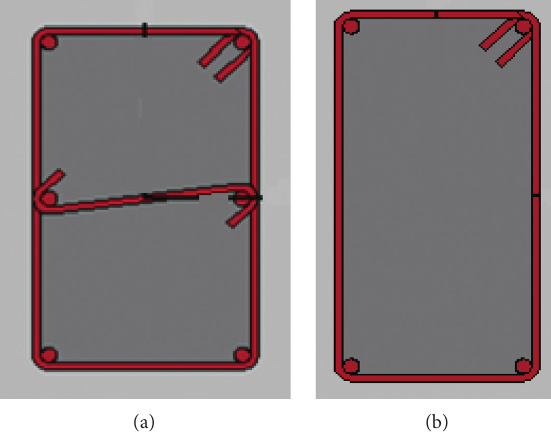
Figure 7: Structural detailing of (a) column detailing and (b) beam